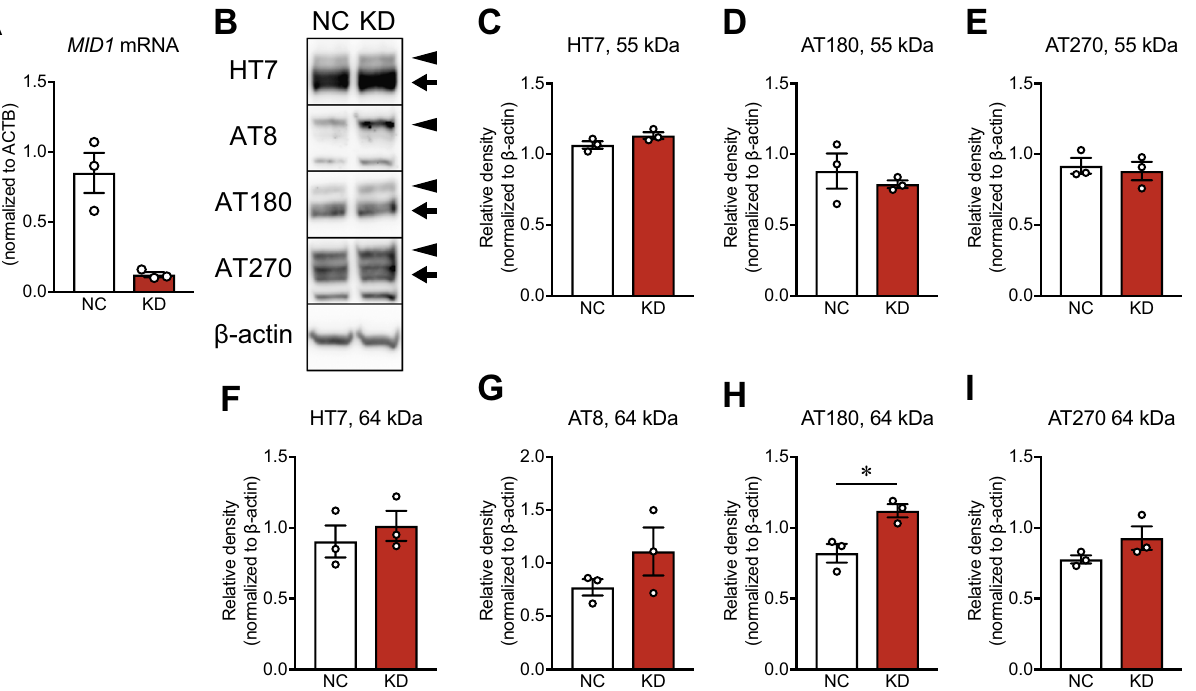
Figure 6. The level of tau accumulation and phosphorylation in MID1 -knockdown cells. HEK293T cells stably expressing human tau with the P301L mutation were treated with negative control siRNA (NC) and MID1 siRNA (KD) for 48 h. ( A ) MID1 mRNA levels in NC-treated and MID1 -knockdown cells. ( B ) Western blots of HT7, AT8, AT180, AT270, and β-actin in the TBS-soluble fractions. Arrows and arrowheads indicate bands at 55 and 64 kDa, respectively. Full-length blots are presented in Supplementary Figure S13. ( C – I ) Densitometric analysis. Data are presented as the mean ± SEM of three independent experiments. * p < 0.05 (Student’s t -test).